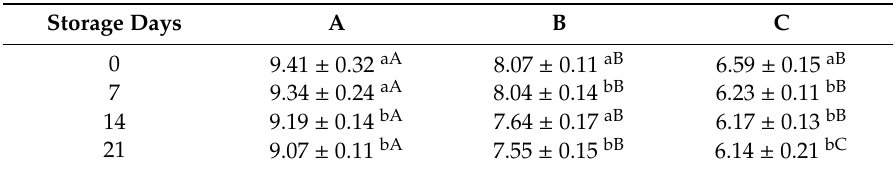
Table 1. Counts of Lactobacillus casei 431 ® (log CFU · g − 1 ) during 21 days of